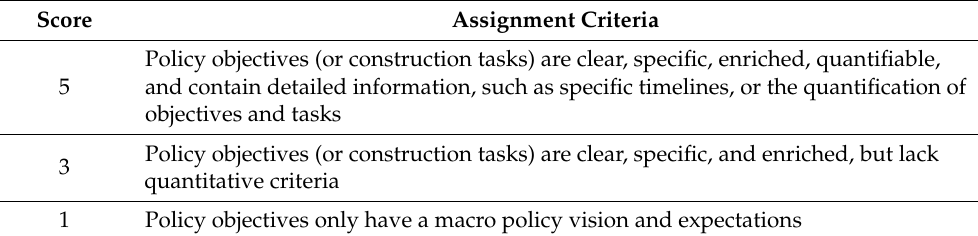
Table 2. Criteria of policy objectives. Score